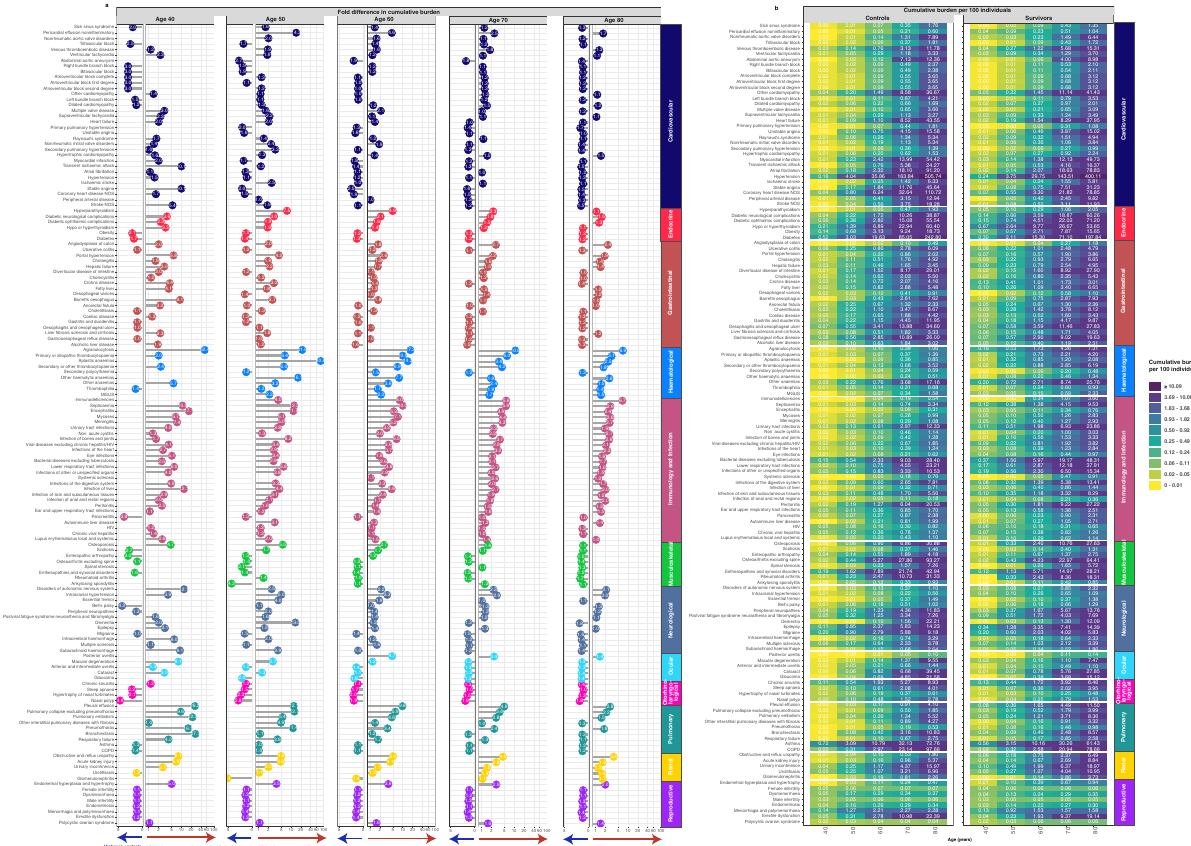
Fig. 1 | Cumulative burden of health conditions for cancer survivors and con- trols from the highest socioeconomic group based on the Index of Multiple Deprivation (IMD). Health conditions were rank-ordered according to the fold difference at age 60 in individuals from the lowest socioeconomic group (see corresponding results for the lowest socioeconomic group in Supplementary Fig. 1). a Lollipop graphs depict the fold difference of cumulative burden in survi- vors versus controls for different age groups. The fold difference is annotated in each lollipop. Conditions that have a higher cumulative burden in survivors are shownontherightsidewithineachage-speci fi cplot,whileconditionswithahigher